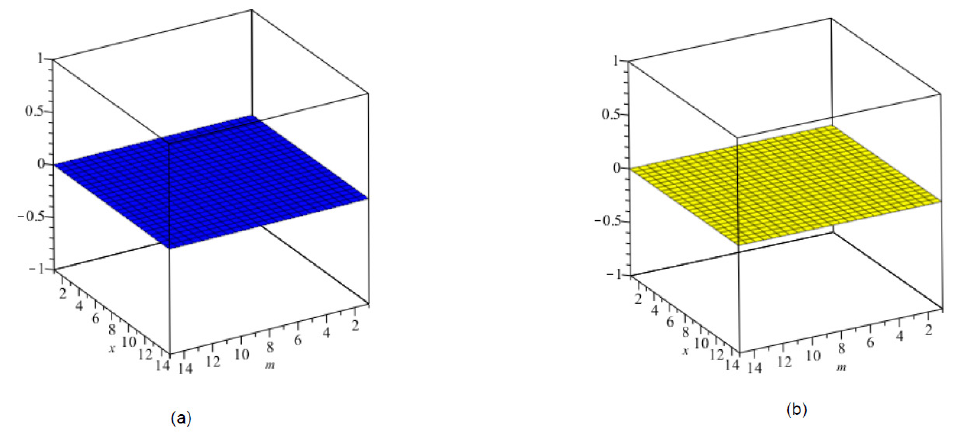
Figure 8 : (a) 1 st Zagreb index (b) 2 nd Zagreb